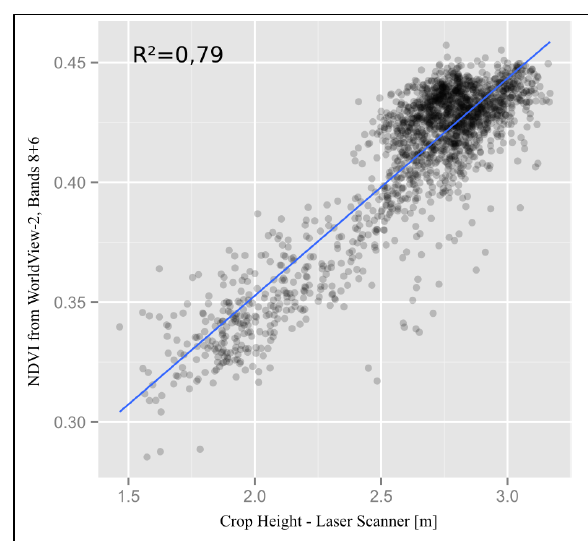
Figure 7. Correlation of NDVI from WorldView-2 (August 7 th ) and CSM-derived plant height from July 31th